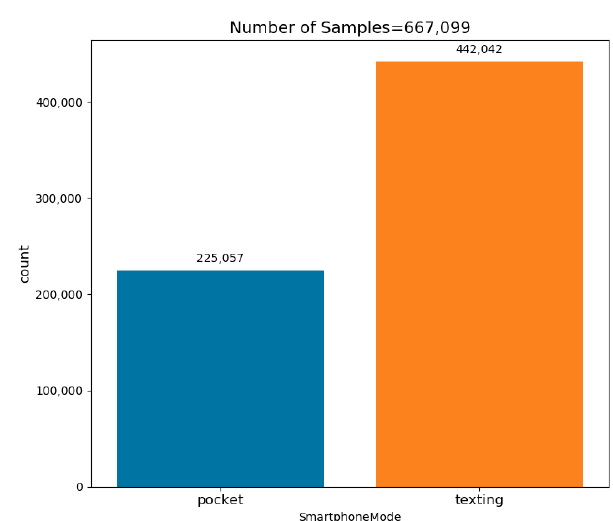
Figure A1. The HTA dataset’s sample distribution to each smartphone location.